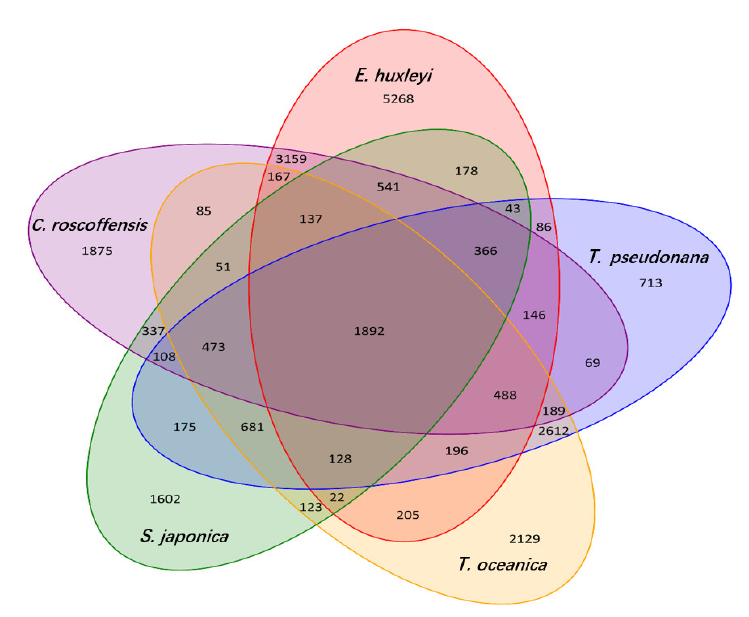
Figure 4. Common and unique gene families in five groups. Venn diagram showing comparison of shared and unique protein-coding genes among Chrysotila roscoffensis , Emiliania huxleyi , Thalassiosira pseudonana, Thalassiosira oceanica , and Saccharina japonica based on orthology analysis.